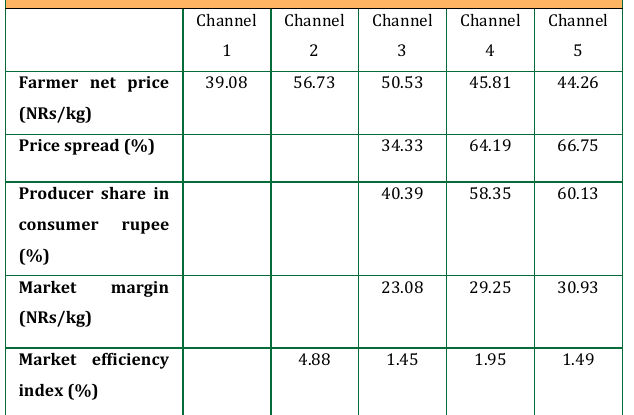
Table 2: Margin and market efficiency in different channels